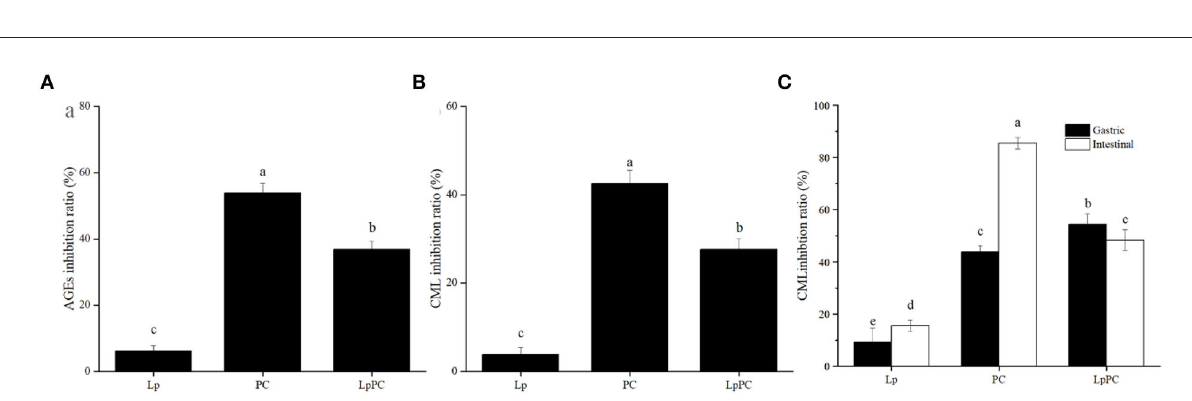
FIGURE2 Inhibition ratios of inoculated litchi pericarp oligomeric procyanidins (LPOPCs) on fluorescent advanced glycation end product (AGEs) and carboxymethyl lysine (CML) formation. Fluorescent AGEs (A) , CML in simulated food processing system (B) , and CML in gastrointestinal digestion system in vitro (C) . LP, L. plantarum group; PC, non-inoculated LPOPCs group; LpPC, inoculated LPOPCs